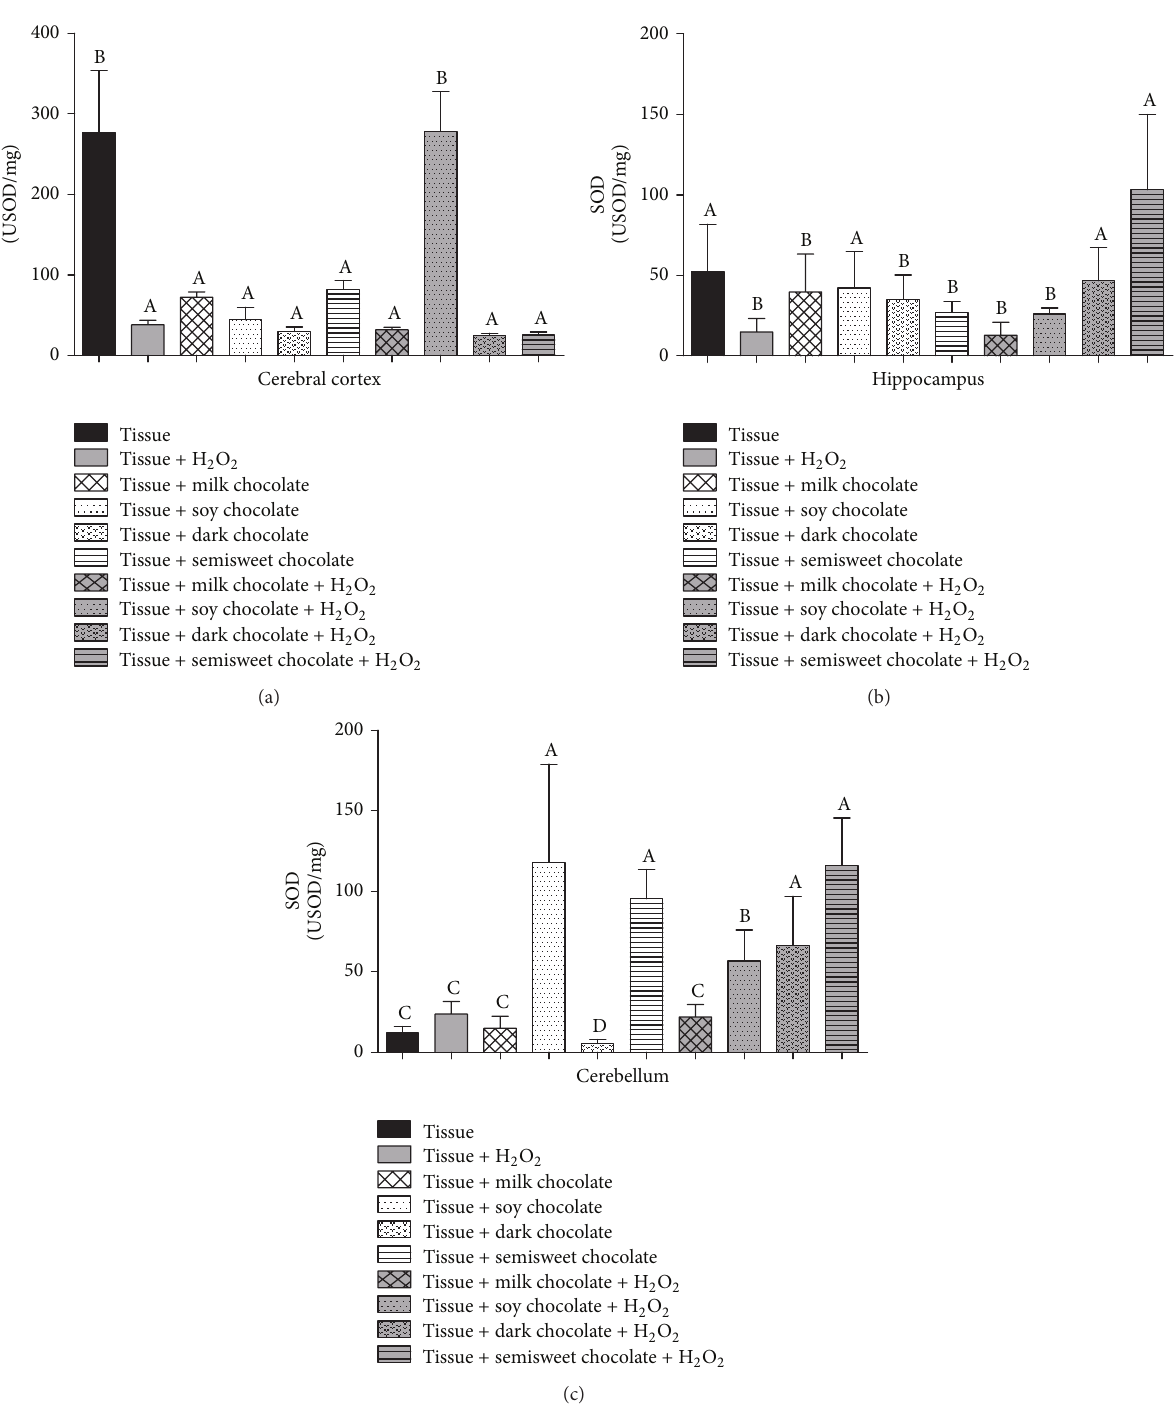
Figure 4: Antioxidant activity of the SOD enzyme in cerebral cortex (a), hippocampus (b), and cerebellum (c) of Wistar rats treated with different chocolate types with or without hydrogen peroxide. Different letters show statistical difference between them ( 𝑝 < 0.05 ).